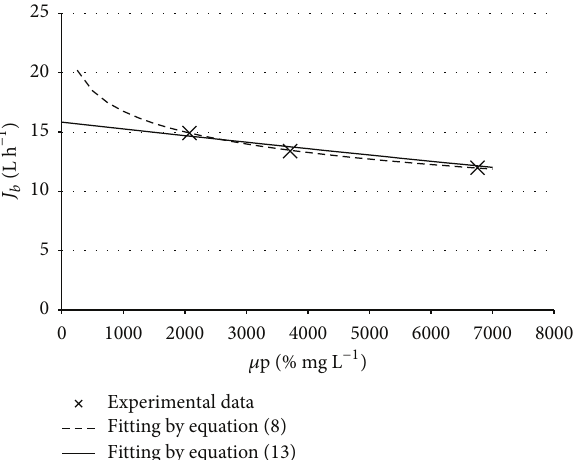
Figure 2: Comparison of the old fitting curve by (8) and the new fitting curve by